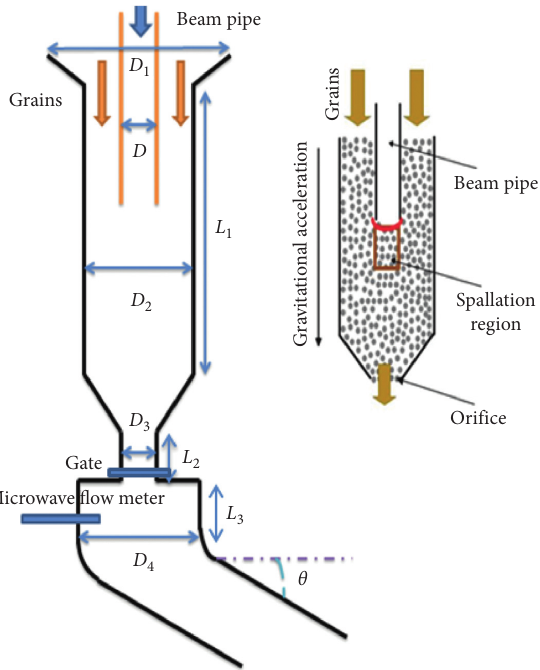
Figure 2: Experimental target model